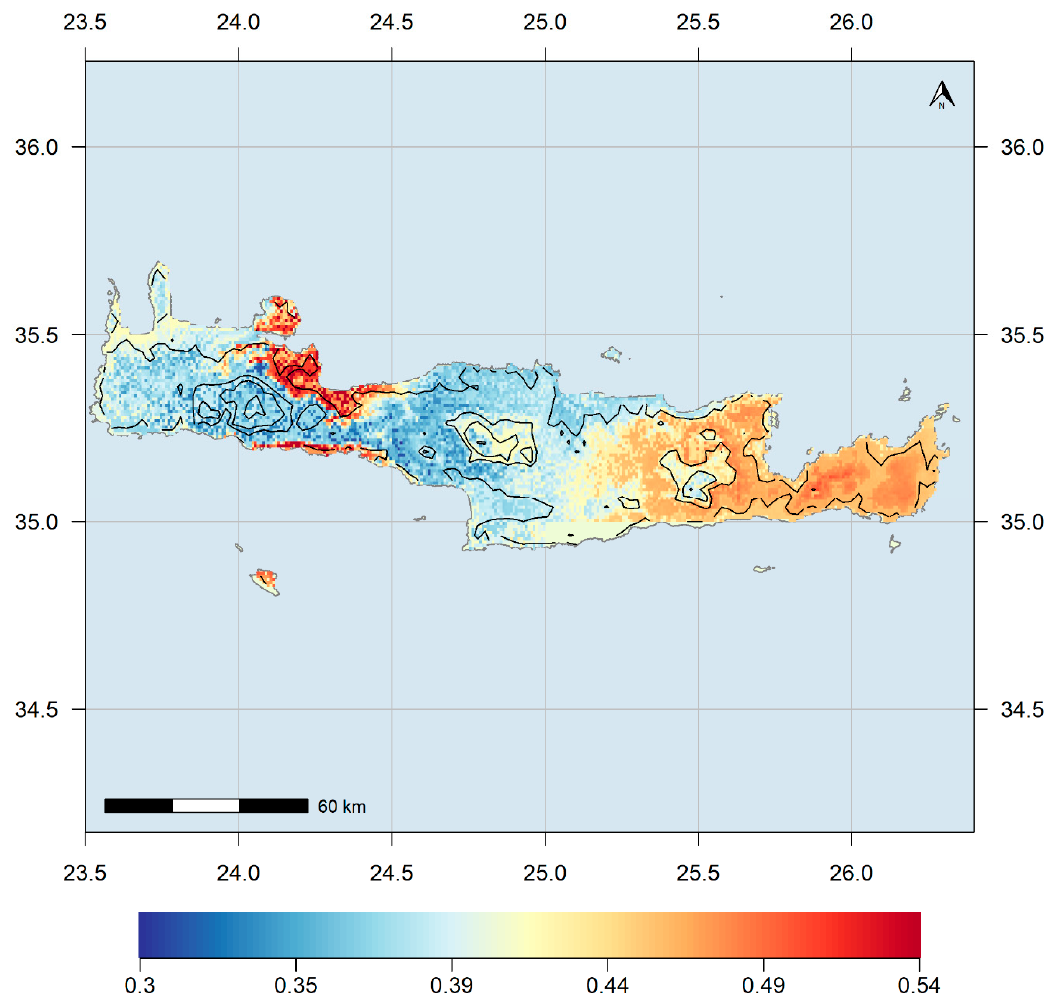
Figure 5. Species turnover as calculated through the GDM framework for the SIE assemblages between the current time-period and the BCC 2.6 Global Circulation Model (GCM) and Representative Concentration Pathway (RCP) combination.